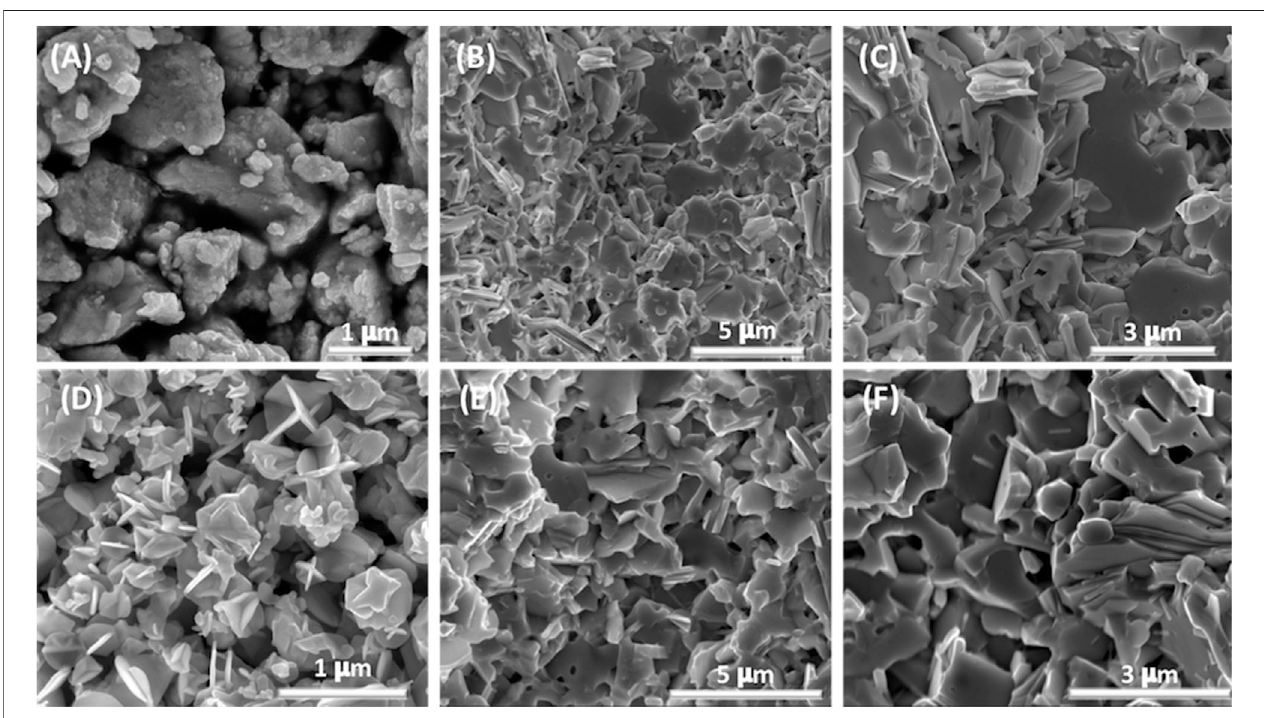
FIGURE 2 | FE-scanning electron microscopy micrographs of (A) as-milled MA-Bi 2 Te 3 , (D) as-synthesized MW-Bi 2 Te 3 , and SPS sintered fractured (B,C) MA- Bi 2 Te 3 and (E,F) MW-Bi 2 Te 3